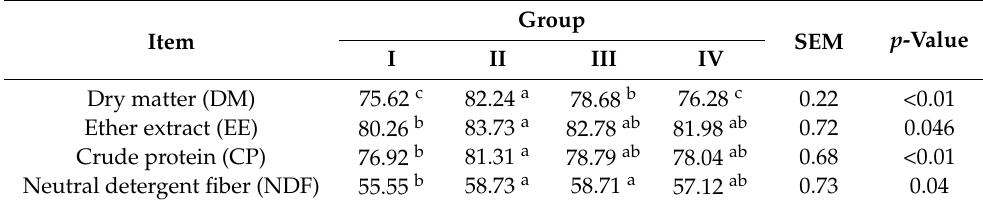
Table 4. Effects of TMR processing of mulberry leaf on apparent digestibility of black goats